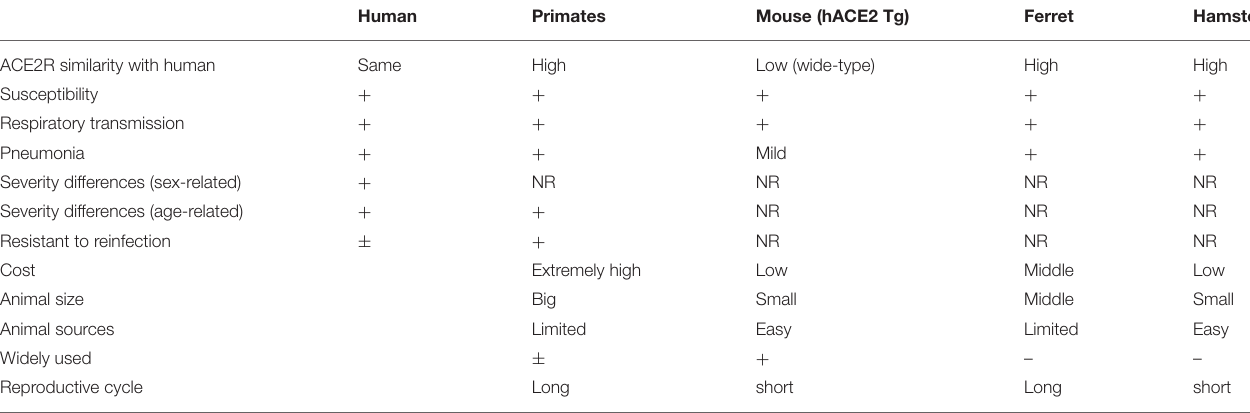
TABLE 1 | Comparison of animal models and human COVID-19 features. Human Primates Mouse (hACE2 Tg) Ferret Hamster ACE2R similarity with human Same High Low (wide-type) High High Susceptibility + + Respiratory transmission